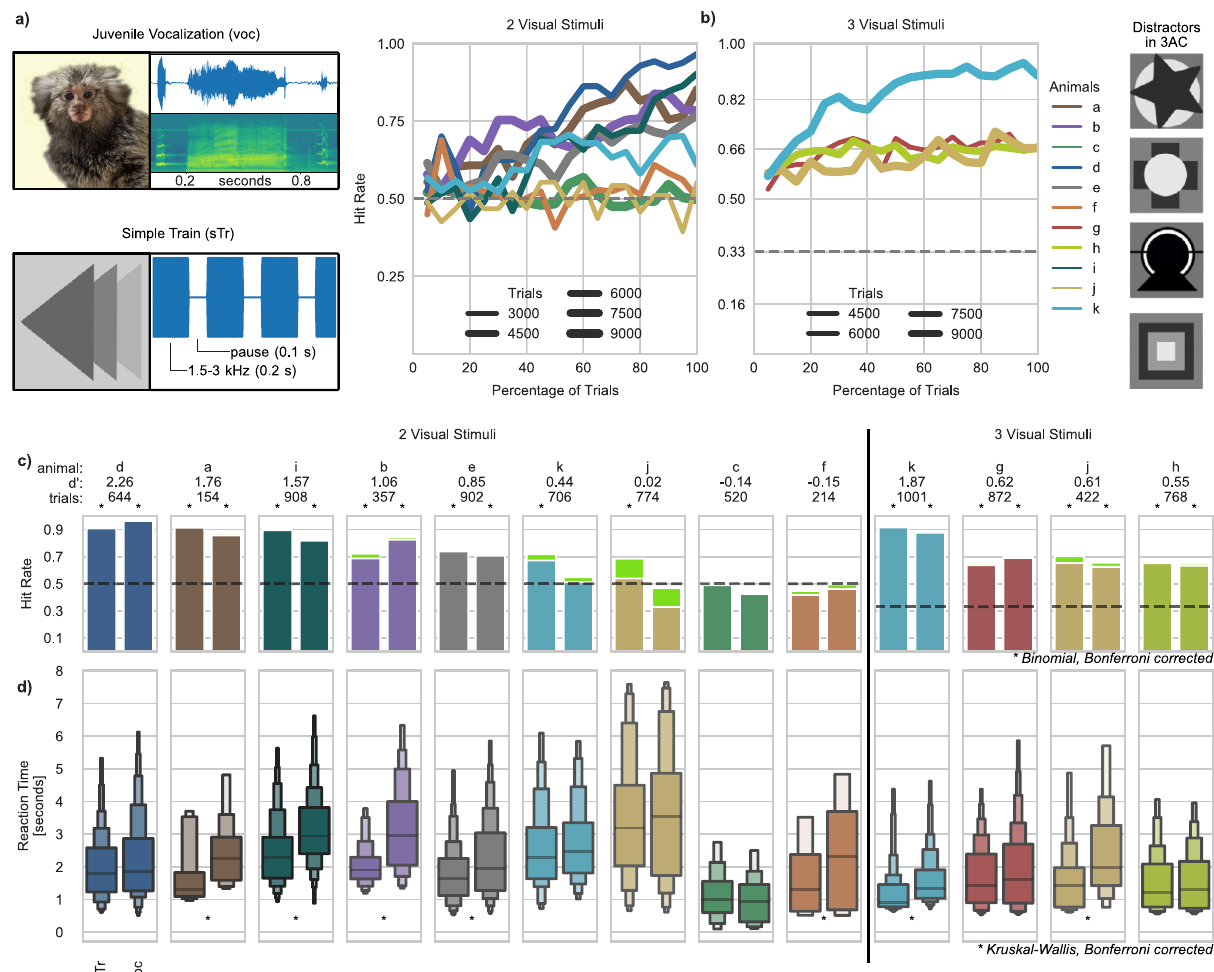
Fig. 3 Stimuli and results from the Audio-visual association experiment. a , b Visual and acoustic stimuli combinations used and hit rate as a function of percentage of trials performed, for different animals (colored lines) and across tasks. Hit rate, as a function of the percentage of trials performed by each animal, is grouped into bins of 5%. Line thickness represents the number of trials of each animal in each panel. Dashed lines at 0.5 and 0.33 represent the chance level for the two tasks. c Hit rate across the last 5 sessions as a function of stimulus type ( “ sTr ” for the pure tone stimulus, “ voc. ” for the juvenile vocalization; green bars indicate ignored trials), with corresponding number of trials and sensitivity index (d ’ ). Stars represent signi fi cance reached for the given stimulus at a Bonferroni post-hoc corrected Binomial test (one-sided test). d Letter-value plots of the reaction times plotted for each stimulus type separately. The central box de fi nes the median and 25th up to 75th percentile. Successively narrower boxes are drawn between the 1/8*100th and 7/ 8*100th, the 1/16*100th and 15/16*100th, and so on, percentile. Stars represent signi fi cant statistical difference in reaction times between the two stimuli at a Bonferroni post-hoc corrected Kruskal – Wallis Test (one-sided test). Statistics and N number for panels ( c ) and ( d ) are given in Table